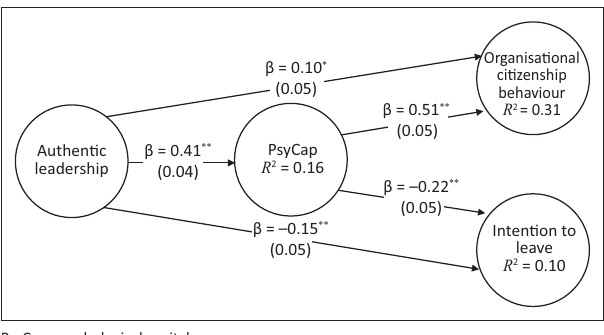
FIGURE 1: The structural model of perceived authentic leadership, PsyCap, organisational citizenship behaviour and intention to leave.